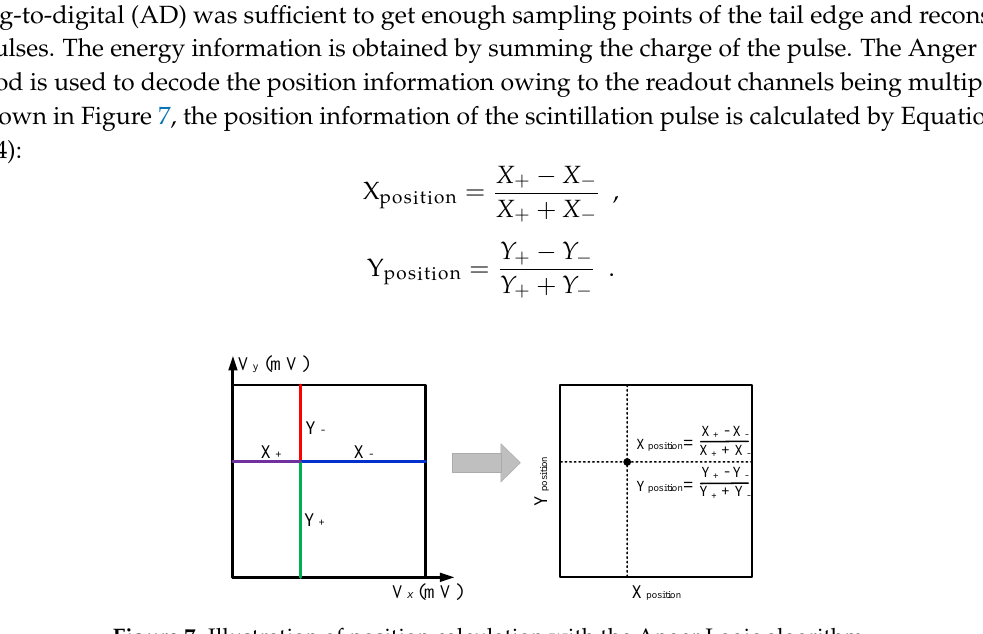
Figure 7. Illustration of position calculation with the Anger Logic